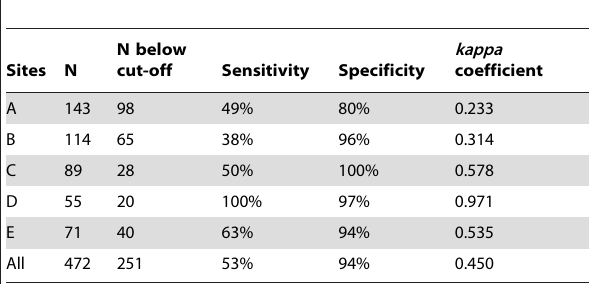
Table 6. Clinical agreement between PointCare NOW and Reference method at 2010 WHO guidelines in adults.